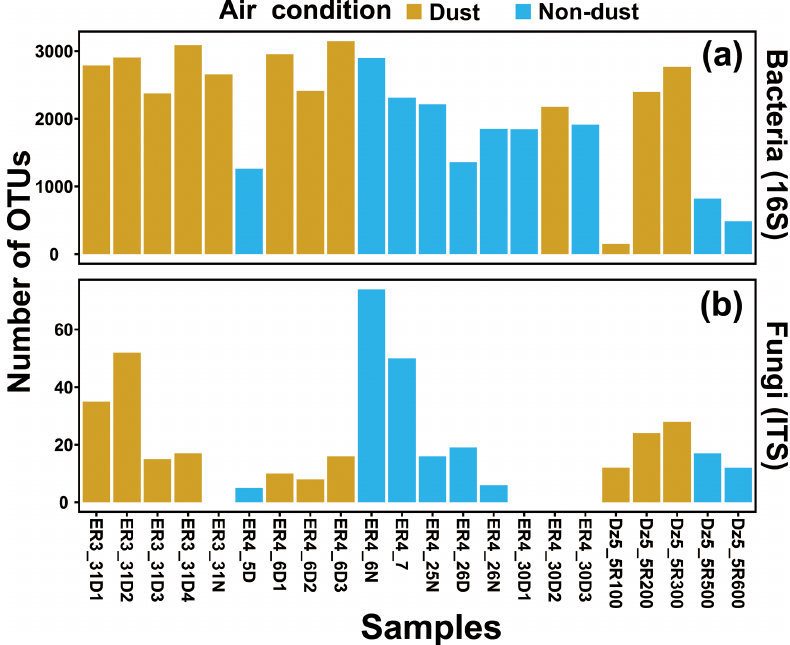
Figure 11. Number of OTUs for bacteria (a) and fungi (b)